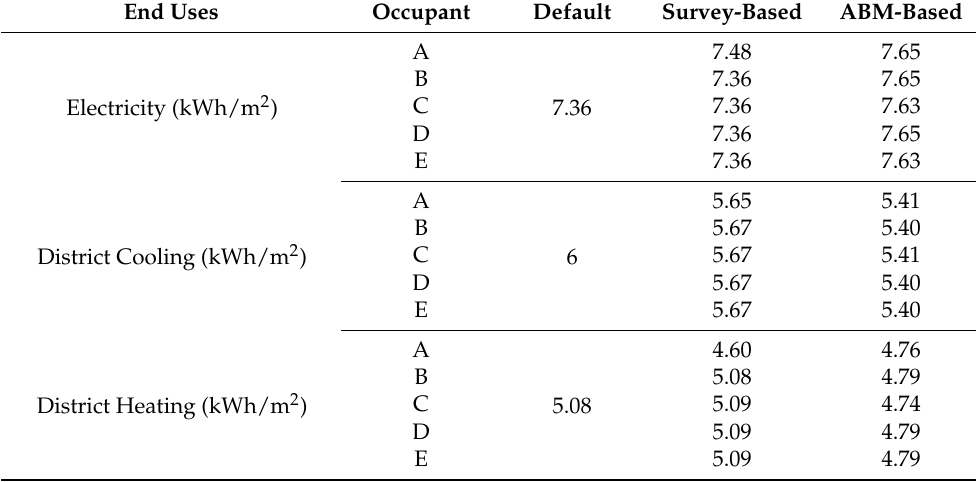
Table 3. End uses of case study building.